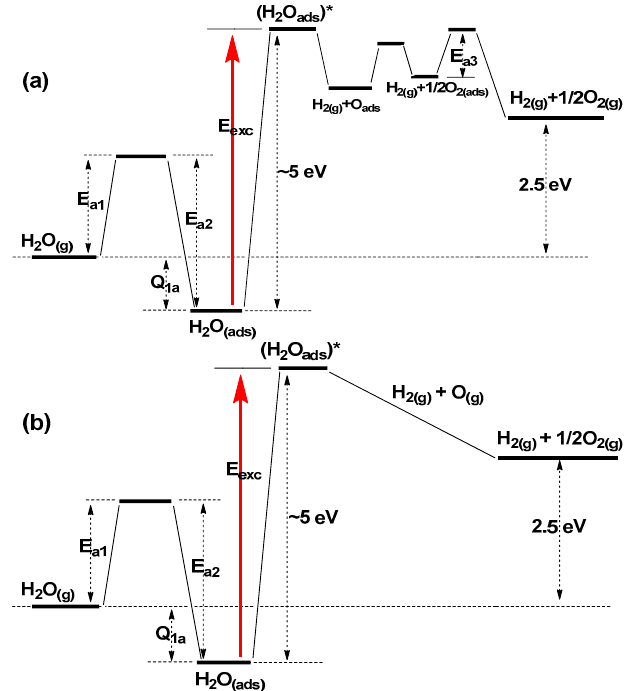
Figure 7. Qualitative schematic illustration of two possible reaction pathways ( a ) and ( b ) for a one-photon induced photolysis of adsorbed water in the presence of a suitable photocatalyst: ( a ) case where photolytic oxygen forms as adsorbed species with subsequent recombination to chemisorbed molecular oxygen and thermally activated desorption; ( b ) case where recombination of the primary water decomposition product occurs in the gas phase without chemisorption.